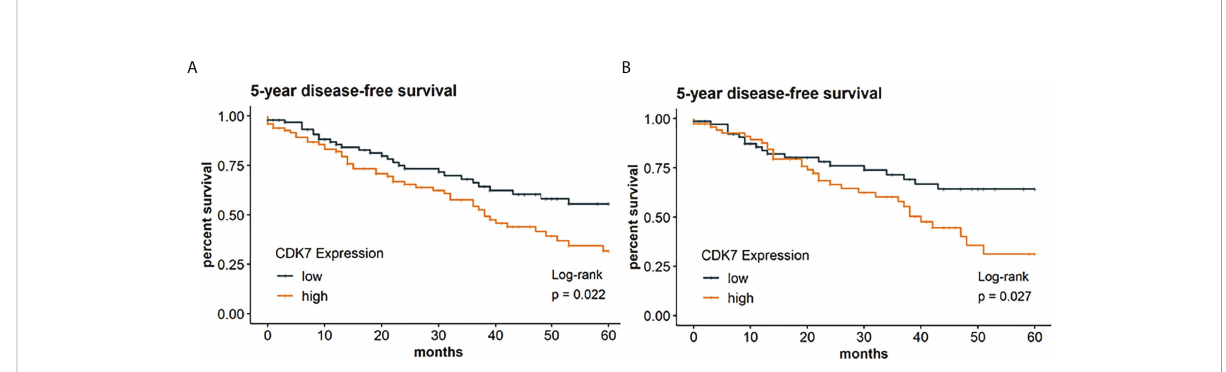
FIGURE 5 Kaplan Meier graphs with a p-value of Log-rank test of (A) 5-year disease-free survival of the whole cohort and (B) 5-year disease-free survival of the subcohort of adNSCLC. Median of CDK7 expression was used to stratify the cohort in two groups with expression above median considered as high expression and expression below median considered as low expression. Upregulation of CDK7 correlated signi fi cantly with a shorter DFS for the whole cohort and group of adNSCLC (p=0.0022 and p=0.0027,